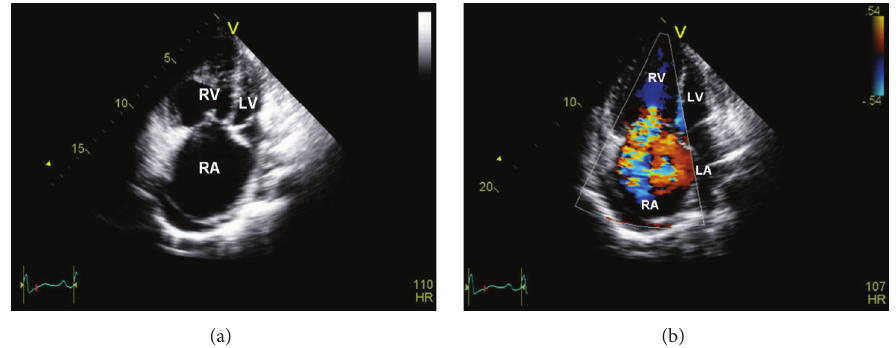
Figure 2: (a) Echocardiography apical view at end systole showing markedly enlarged right ventricle (RV) and right atrium (RA) and compressed left ventricle (LV). (b) Color echo Doppler image showing severe tricuspid regurgitation. LA = left